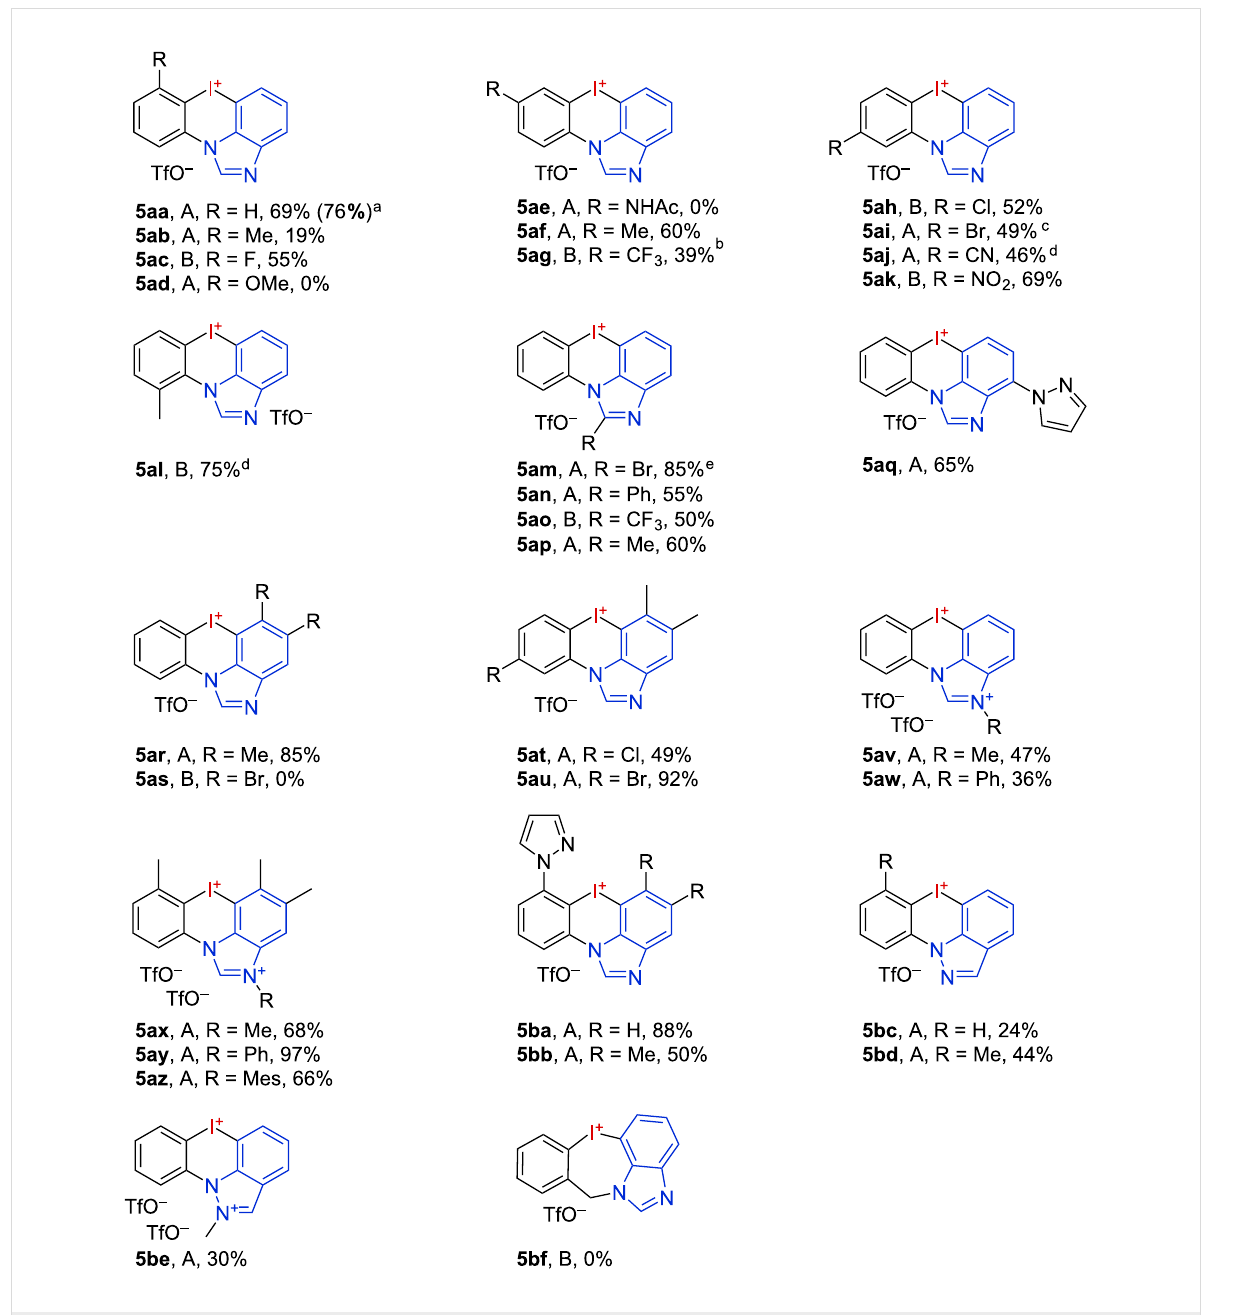
Figure 2: Synthesis of a set of azoiodazinium salts 5 . Method A: Iodoarene 4 (200 µmol) and m CPBA (1.1 equiv) were dissolved/suspended in DCM (1 mL), TfOH (2.5 equiv) was added, and the reaction mixture was stirred for 72 h at 40 °C. Method B: Iodoarene 4 (200 µmol) and m CPBA (1.3 equiv) were dissolved/suspended in DCM (1 mL), TfOH (5.0 equiv) was added, and the reaction mixture was stirred for 14 d at 65 °C. a 6.00 mmol scale, T = 50 °C, b T = 40 °C, c T = 80 °C, t = 6 d, d t = 7 d, e 0.3 equiv of DCM were included in the product.